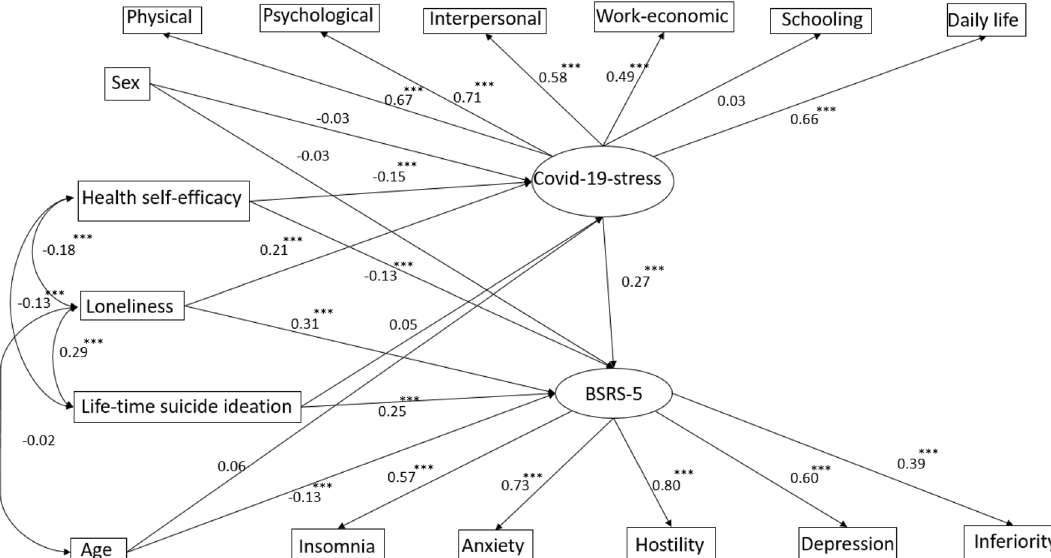
Figure 2. The structural equation model for psychological distress by COVID-19 stressors with control for related psychosocial factors. Root mean square error of approximation (RMSEA) = 0.047 < 0.05, goodness of fit index (GFI) = 0.969 > 0.9, adjusted goodness of fit index (AGFI) = 0.954, Cmin/DF = 5.607, p <